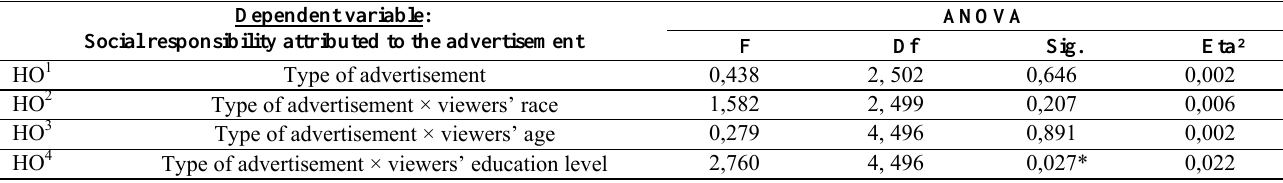
Table 2: Hypotheses HO 1 to HO 4 – ANOVA Dependent